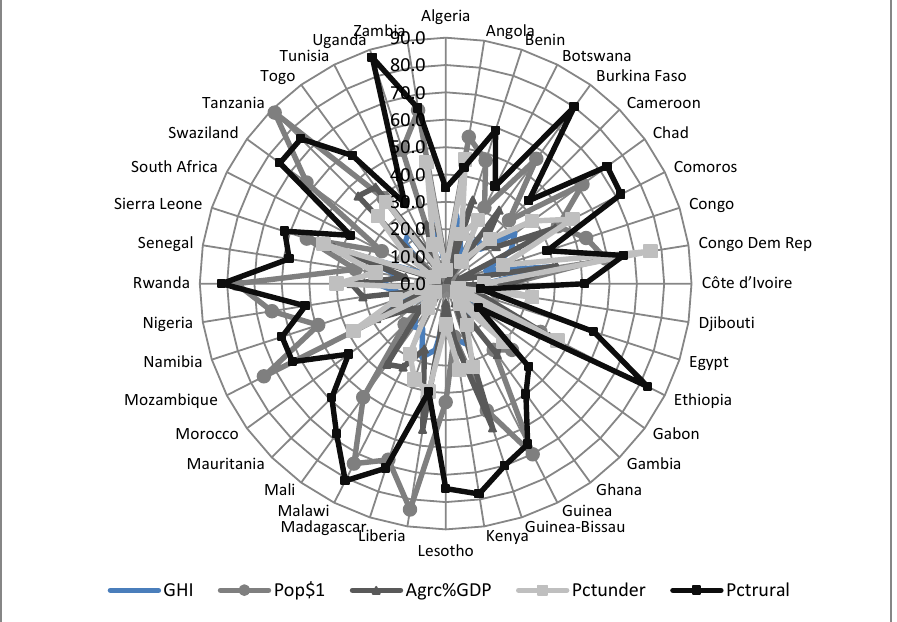
Figure 1: Summary profile of countries by indicator Source: World Bank, 2010; FAO,